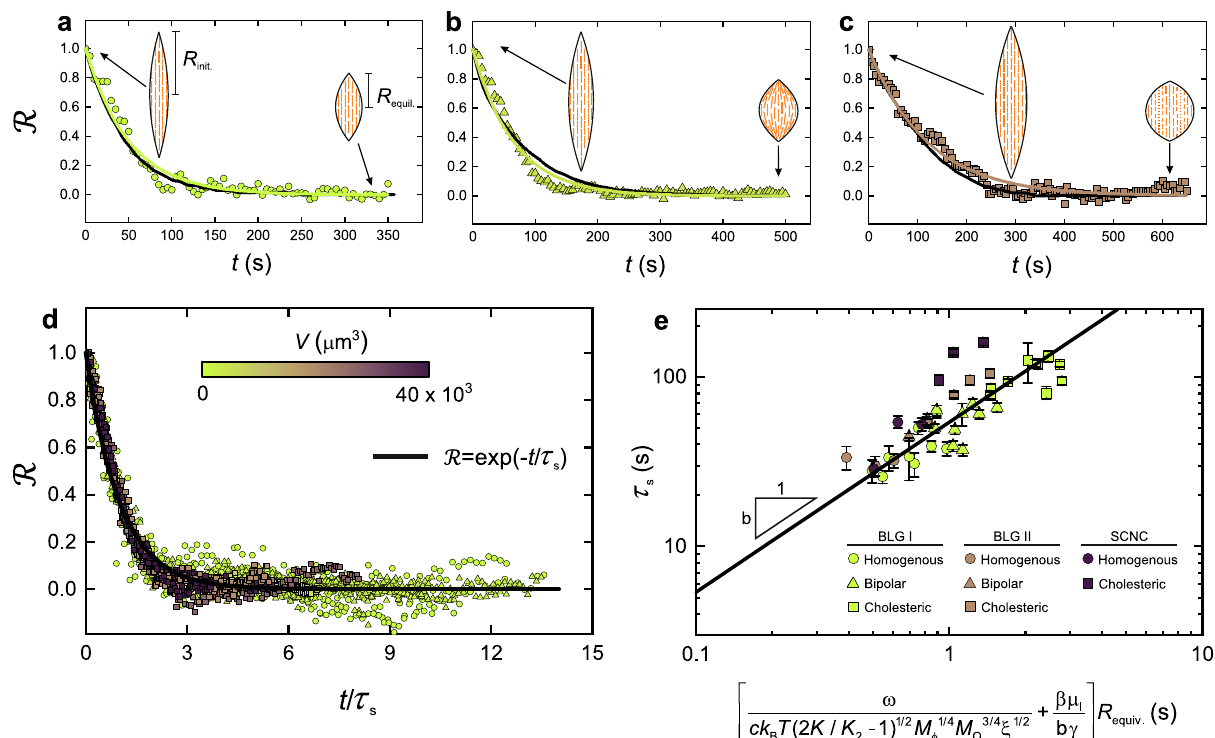
where R equil. , R init. , and R ( t ) are the half-length Fig. 2 Shape relaxation of amyloid fi bril liquid crystalline tactoids. a – c Evaluation of R (de fi ned as R t ð Þ(cid:2) R equil : R init : (cid:2) R equil : of the long axis of tactoid at equilibrium, at the initial time, and at a given time t , respectively) with respect to time for tactoids that relax to homogenous, R equiv. ( V 1/3 , with V the volume) = 9.4 µ m ( a ), bipolar, R equiv. = 19.3 µ m ( b ) and cholesteric, R equiv. = 27.8 µ m ( c ) con fi gurations at equilibrium. Symbols and black lines denote the experimental and numerical simulation results, respectively; colored lines show the fi tting ( R ¼ exp (cid:2) t τ s characteristic shape relaxation time, τ R with respect to scaled time t ⁄ τ R ¼ exp (cid:2) t s . d Evaluation of s resulting in a universal curve, τ s the different classes of tactoids with various volumes and initial elongation values. e Circle, triangle, and square symbols denote homogenous, bipolar, and cholesteric tactoids, respectively. The error bars represent standard deviation. The developed theory, solid line, predicts the τ s for different classes of BLG and SCNC liquid crystalline tactoids, con fi rming the generality of our approach to predict the bio-colloidal liquid crystalline tactoids relaxation behavior. Here, ω is the anchoring strength, ck B T is the thermal energy per unit volume of dispersion, K and K 2 are the Frank elastic constants, ξ is the coherence length, M ∅ is the mass mobility, M Q is the rotational mobility, γ is the interfacial tension, βμ I is the effective viscosity, and b is a single constant